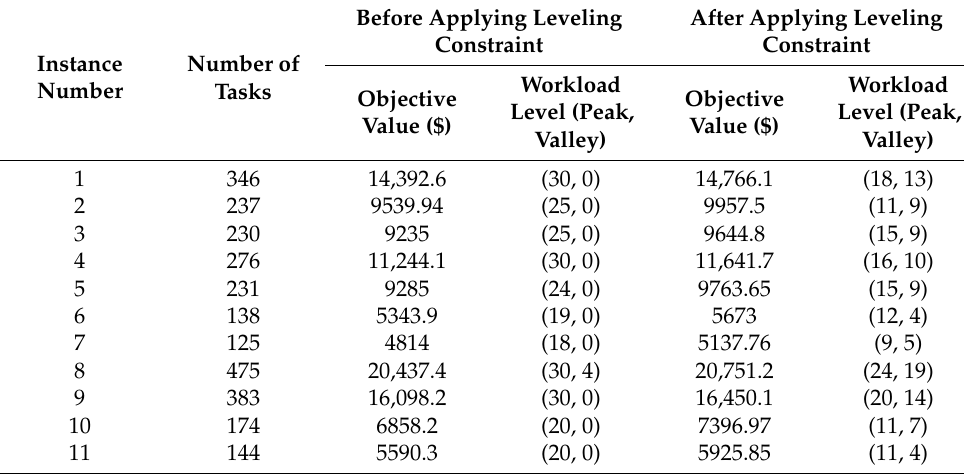
Table 12. A comparison between results before and after applying the leveling